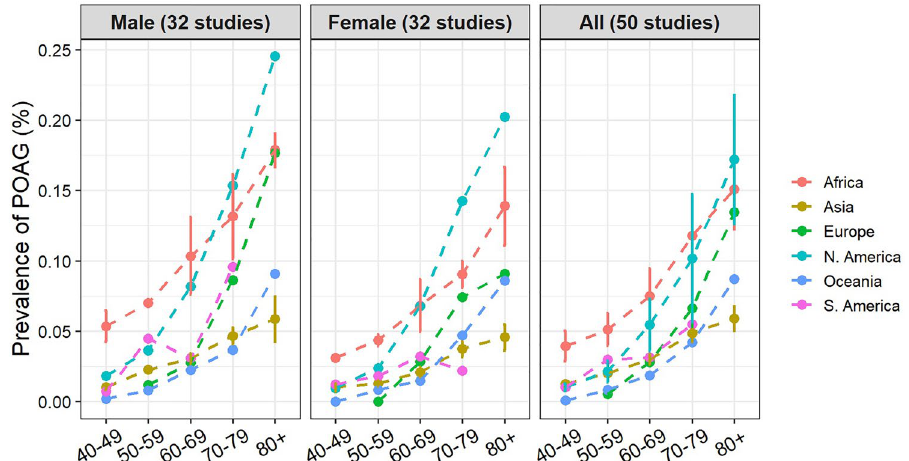
Figure 4. Prevalence of primary open-angle glaucoma for different age groups. Note: the plots for “Male” and “Female” represent studies with data for each gender (n = 32). The plot for “Both” represents data from all studies (n = 50), regardless of whether the prevalence for each gender were reported or not. POAG primary open-angle glaucoma.